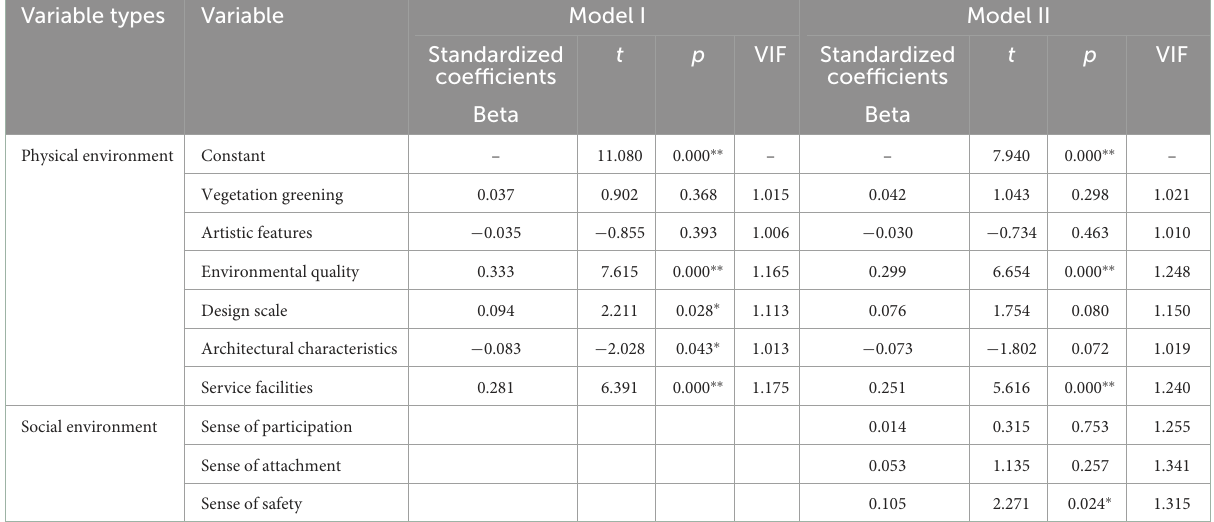
TABLE 7 Results of multilevel regression equation model of sleep quality.